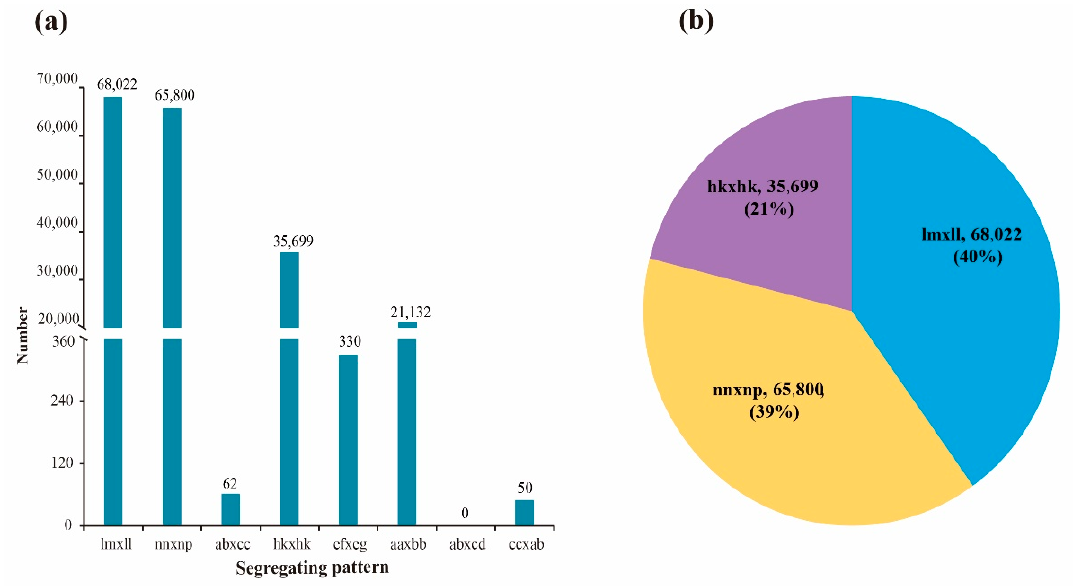
Figure 2. Genotype distribution and number of SNP markers. Note: ( a ), distribution of eight types markers; ( b ), the proportion of three segregation patterns in linkage population.